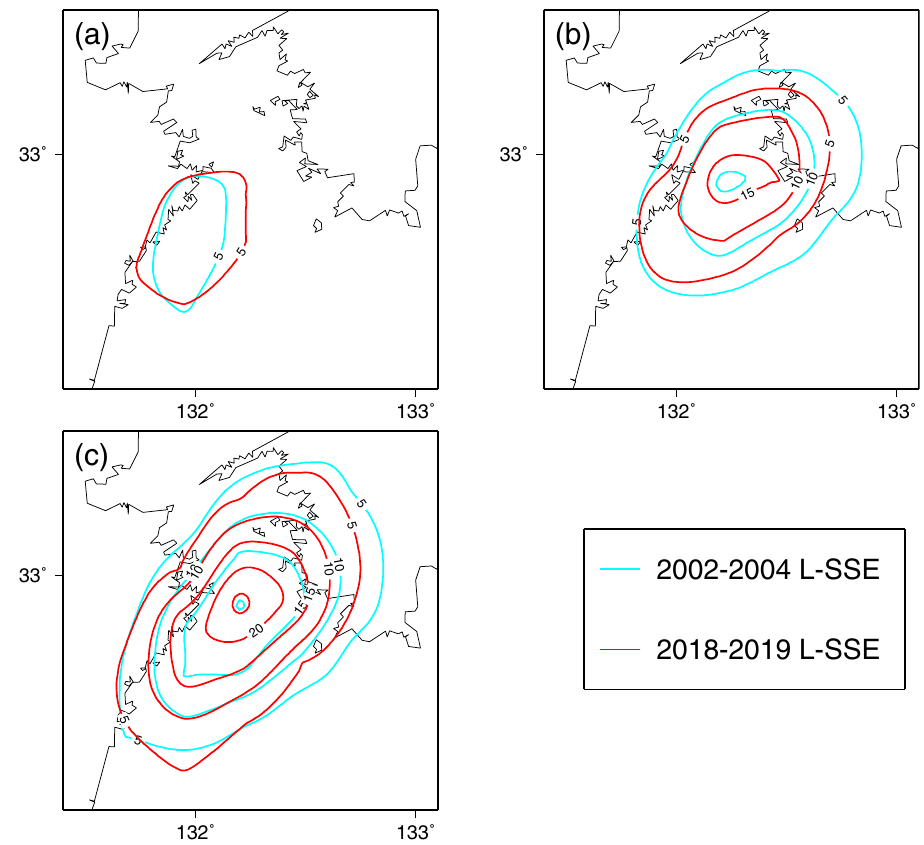
Figure 6. Comparison of slip distributions between the 2018–2019 Bungo Channel L-SSE (in red) obtained in this study and the 2002–2004 L-SSE (in light blue) estimated by Yoshioka et al. 7 . The contour interval is 5 cm. ( a ) Slip distributions of the two first subevents. ( b ) Slip distributions of the two second subevents. ( c ) Total slip distributions of the two